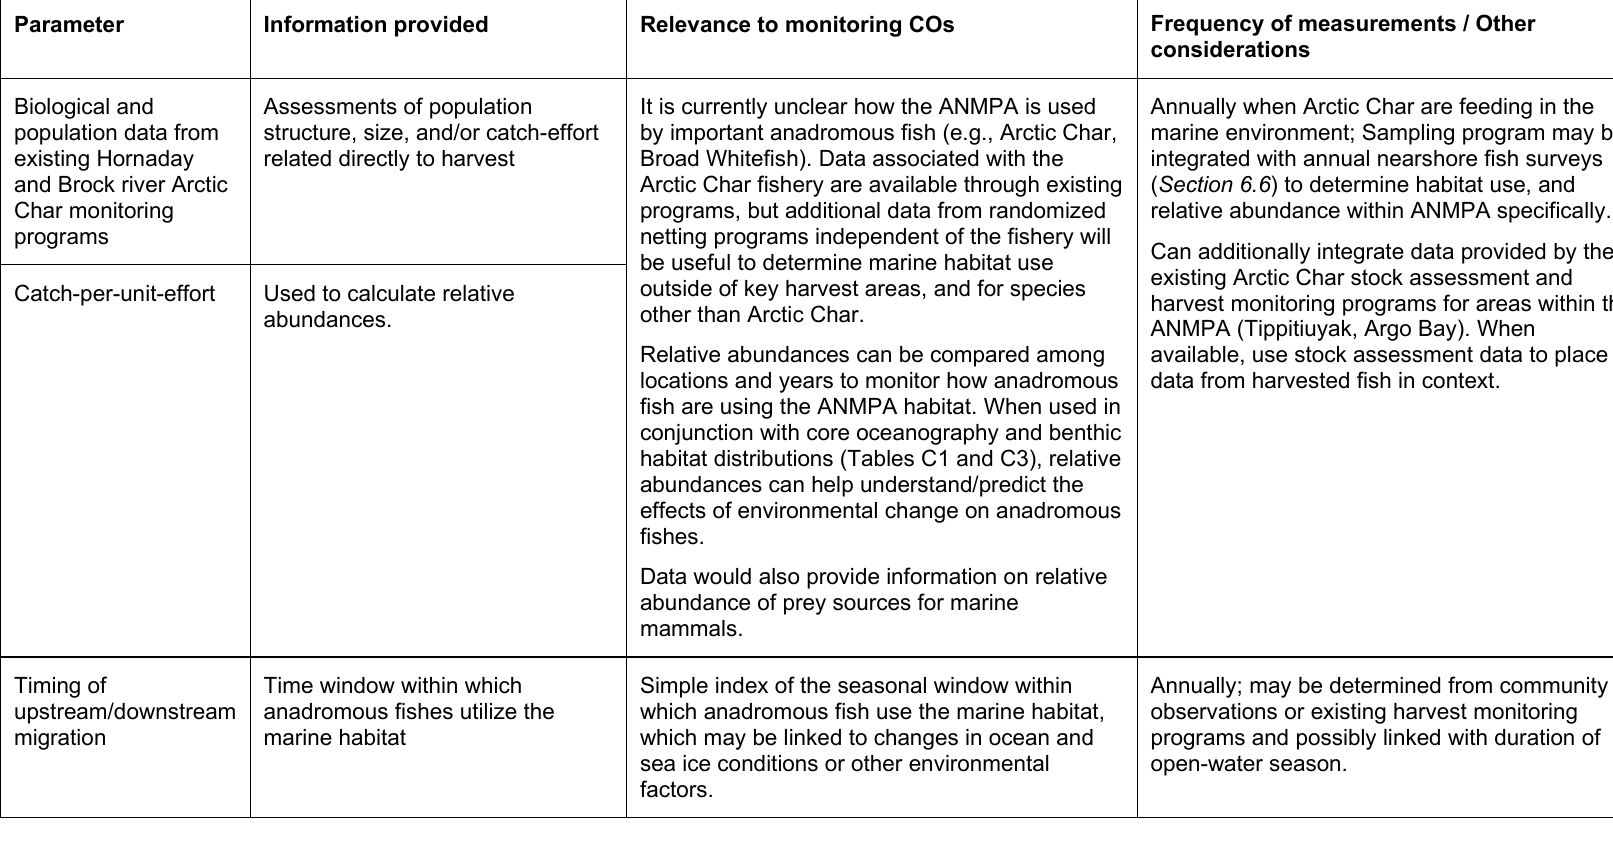
Table C6.8. Key measurement parameters for monitoring anadromous fish relative abundance, habitat use, and population structure (Section